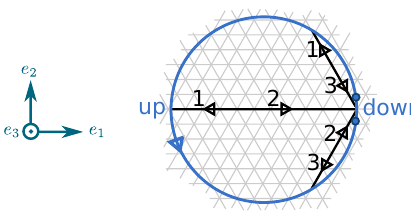
Figure 37 . An unknot L in M = R 3 . We show the projection to the x 1 - x 2 plane; the tendency in the x 3 direction is indicated by the words “up” and “down.” L goes up along most of the circle, then goes down steeply in a small arc; the two marked points are critical points of x 3 . The three possible finite webs are shown in black; they are all exchanges. Generic ij -leaves are shown in gray.